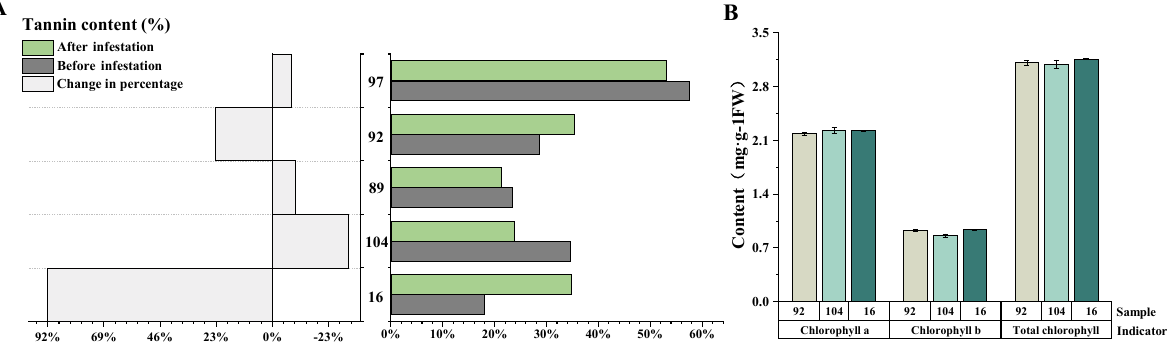
Figure 8. Tannin and chlorophyll content. ( A ) Determination of tannin content in sugarcane leaves before and after infestation treatment, three replicates for each sample. The percentage change was greater than 0 if tannin content increased after infestation, and lower than 0 if it decreased. ( B ) The mean chlorophyll content of the positive first leaf of PPA transgenic sugarcane lines (PPA − 104, PPA − 16) and control sugarcane line (92) at maturity, each in three